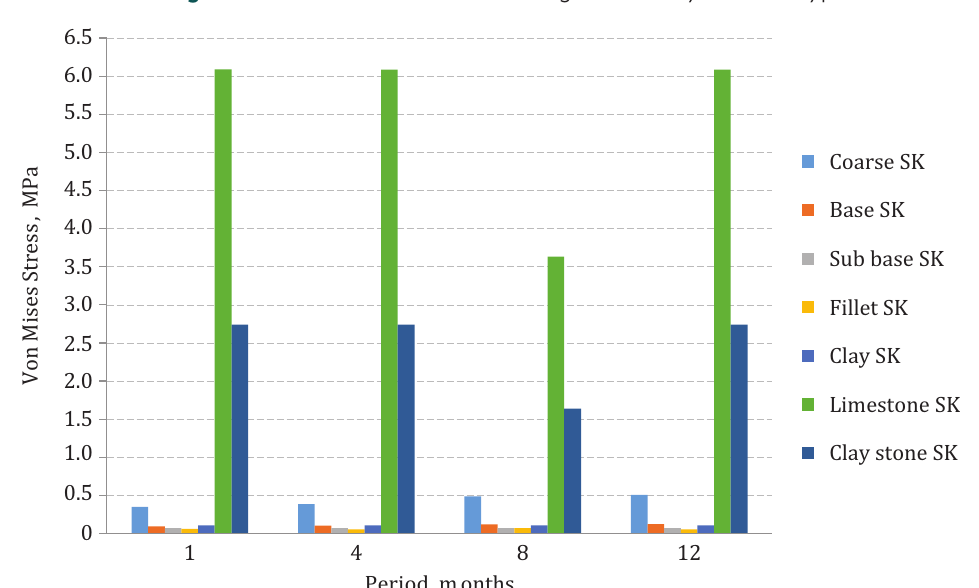
Figure 11. Von Mises stress-time changes of the layers for N-Type